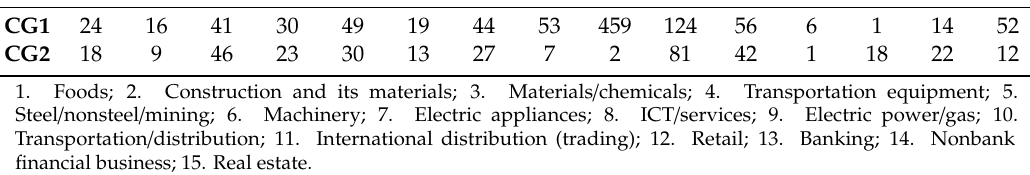
Table 4. Industrial structure of CBs in CG1 and CG2. Each cell denotes the number of CBs.